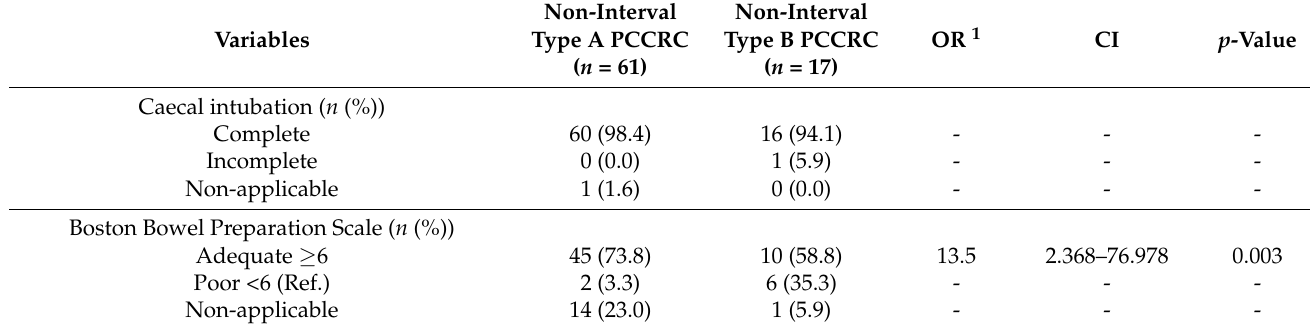
Table 5. Characteristics of non-interval type A PCCRC and non-interval type B PCCRC in terms of the index